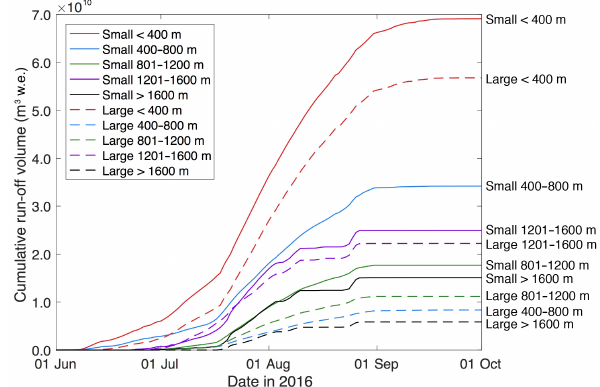
Figure 11. Cumulative run-off volume, from RACMO2.3p2 data (Noël et al., 2018), entering the GrIS over the remainder of the melt season via the moulins opened by rapid lake drainage for small ( < 0 . 125km 2 ) and large ( ≥ 0 . 125km 2 ) lakes for different ice- surface elevation bands, derived from Howat et al. (2014), shown in ma.s.l. in the legend and line labels. Run-off volume is derived within the ice-surface catchments of lakes and is assumed to reach the moulin instantaneously on each day, without any flow